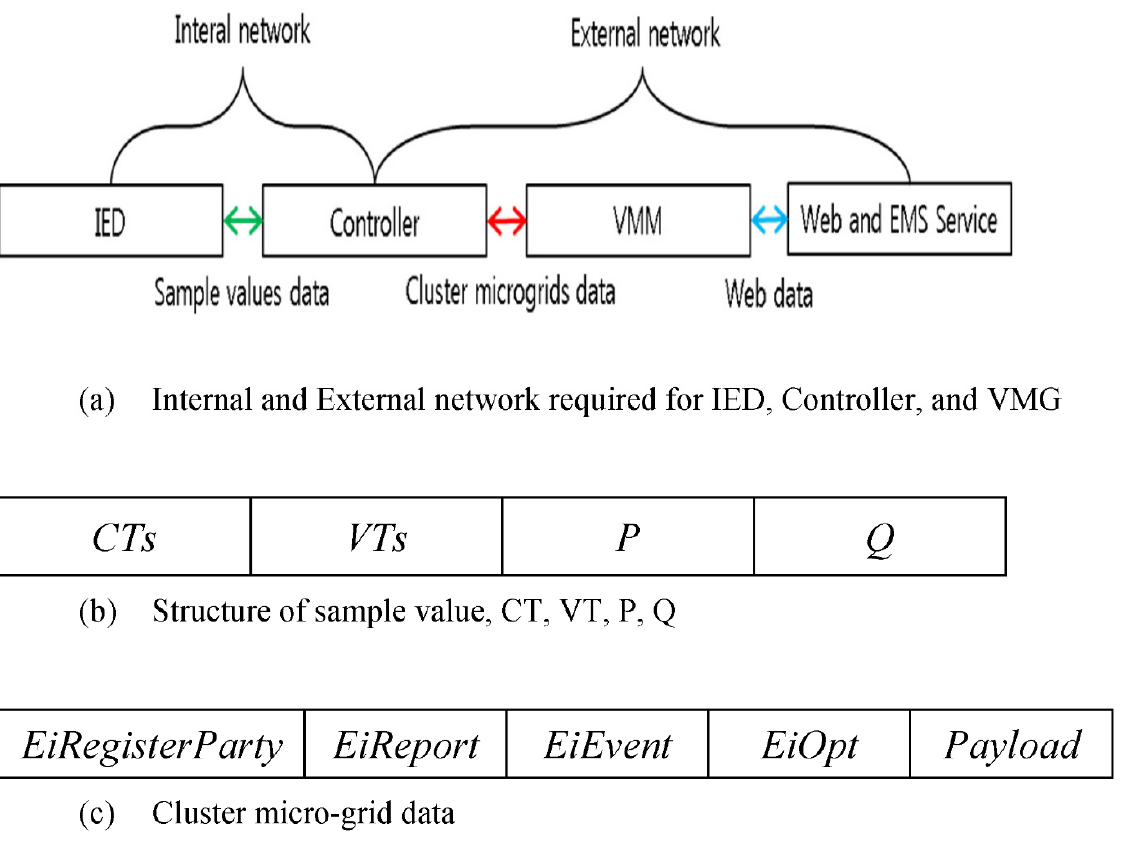
Figure 3. Large-scale distributed system configuration; ( a ) Data transmission requirement; ( b ) Sample value data configuration; ( c ) Cluster microgrid data configuration.